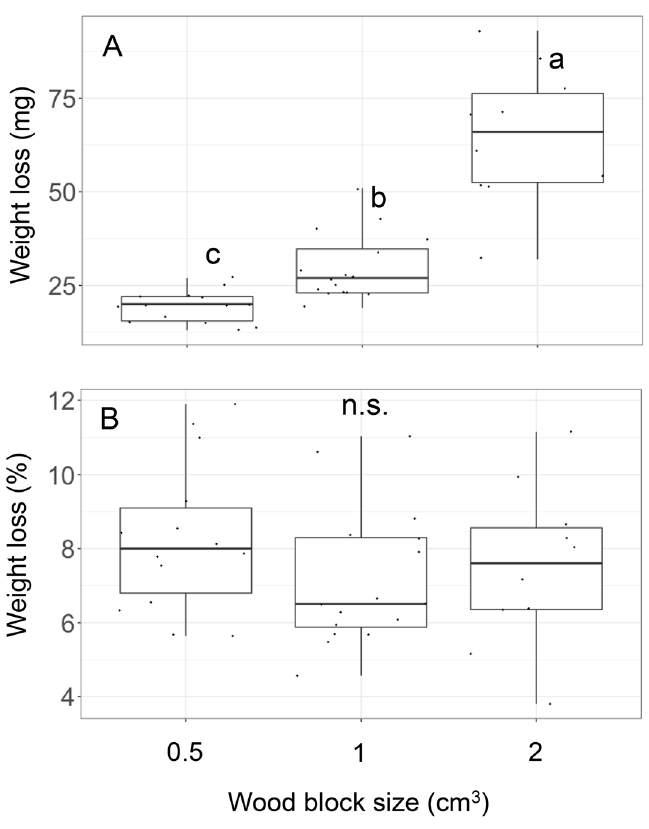
Figure 2. Absolute weight loss ( A ) and percentage weight loss relative to the original weight ( B ) of wood blocks after 2 months of Phanerochaete velutina colonization. Different lowercase letters indicate significant differences between wood block sizes (Nemenyi test, P < 0.05). N.s. indicates no significant difference between wood blocks (Kruskal–Wallis test, chi-squared = 2.2151, df = 2, P = 0.3304). N = 14 for 0.5 cm 3 , 16 for 1 cm 3 , and 10 for 2 cm 3 wood